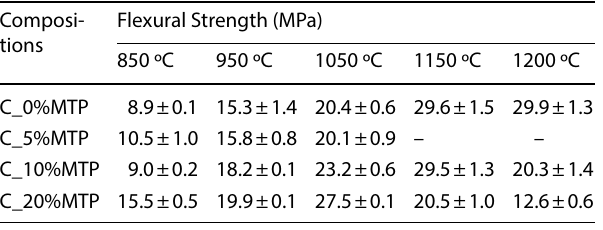
Table 4 Flexural strength evolution with the increase on firing tem- perature for all compositions Composi- Flexural Strength (MPa) tions